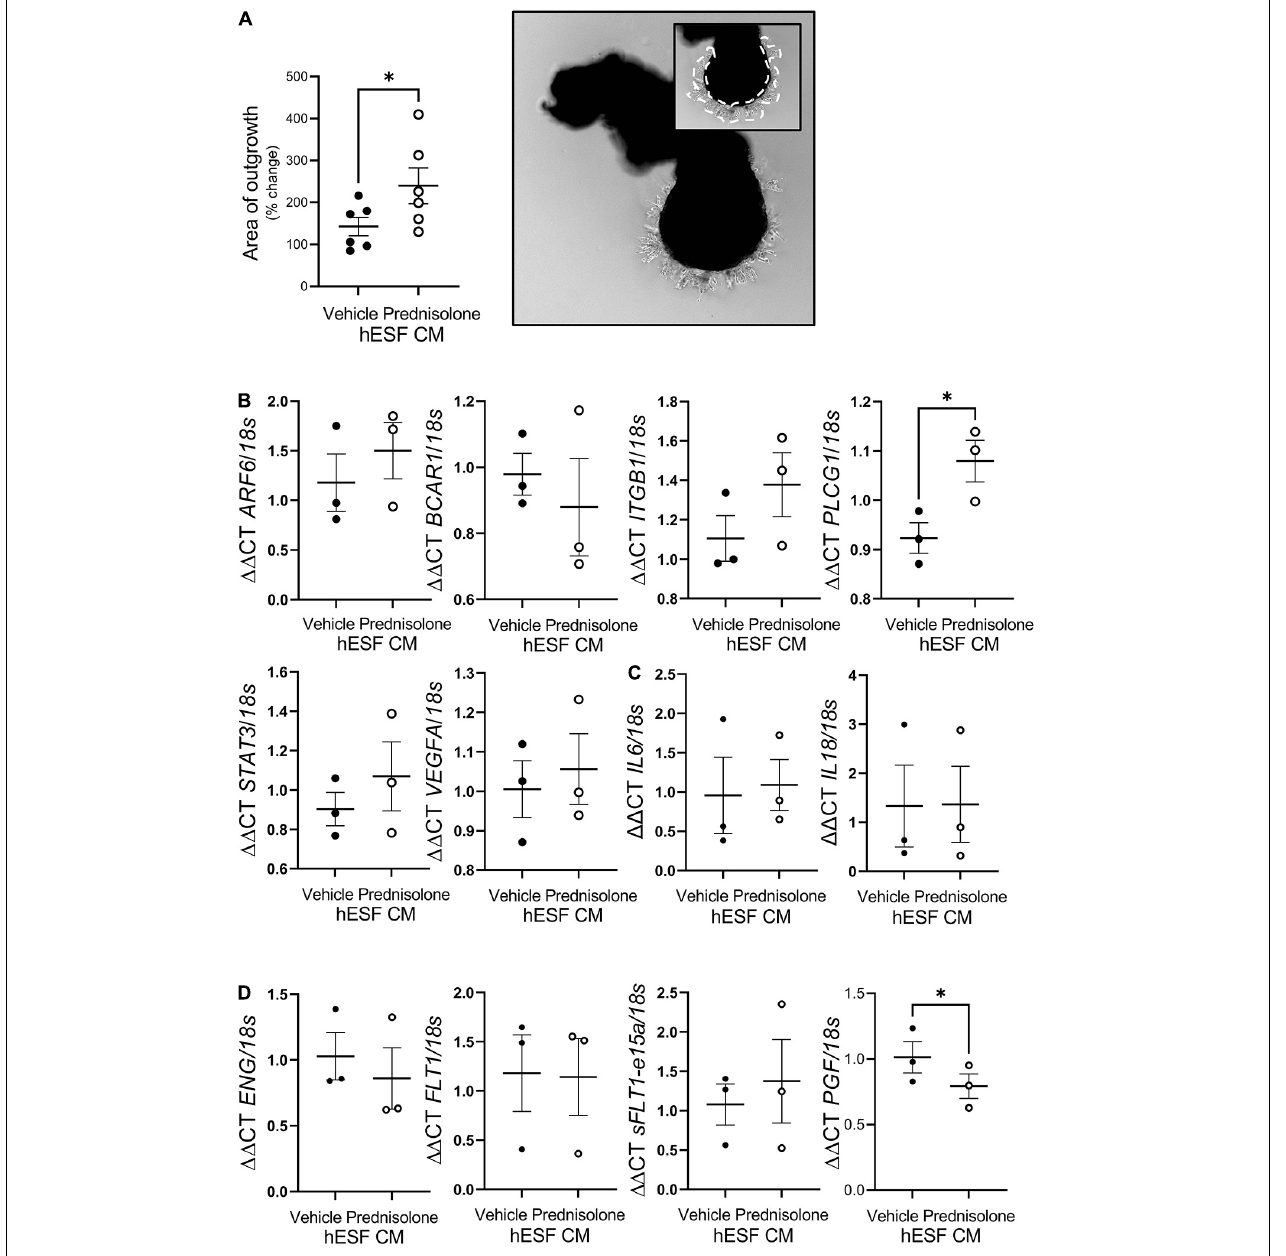
FIGURE 4 | Prednisolone altered human endometrial stromal fibroblast (hESF) regulation of trophoblast function. (A) Extravillous trophoblast (EVT) outgrowth was significantly enhanced by conditioned media (CM) from hESF decidualized in the presence of prednisolone. Image shows representative outgrowth from villous tip. Insert shows area of outgrowth highlighted by dotted line. Paired t -test, n = 6. (B) EVT PLCG1 expression was significantly increased by treatment with CM from hESF decidualized in the presence of prednisolone. Paired t -test, n = 3/group. (C) EVT IL6 and IL18 expression was not altered by treatment with CM from hESF decidualized in the presence of prednisolone. Paired t -test, n = 3/group. (D) EVT PGF expression was significantly inhibited by treatment with CM from hESF decidualized in the presence of prednisolone. Paired t -test, n = 3/group. Data presented as mean ± SEM; *P <